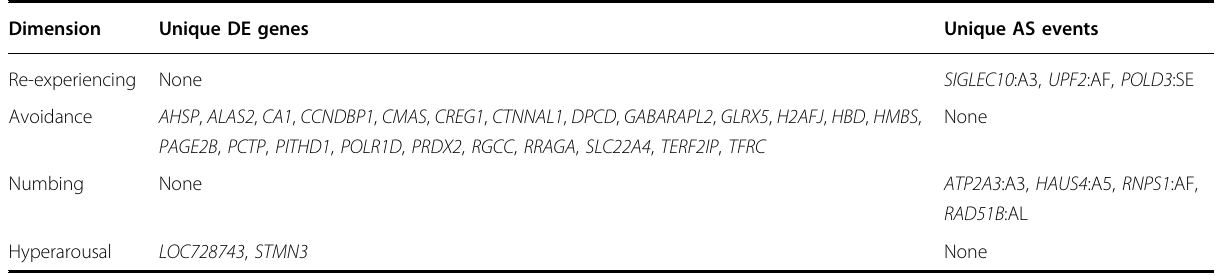
Table 1 List of DE genes and AS events unique to each PCL dimension analysis. Dimension Unique DE genes Unique AS events Re-experiencing None SIGLEC10 :A3, UPF2 :AF, POLD3 :SE Avoidance